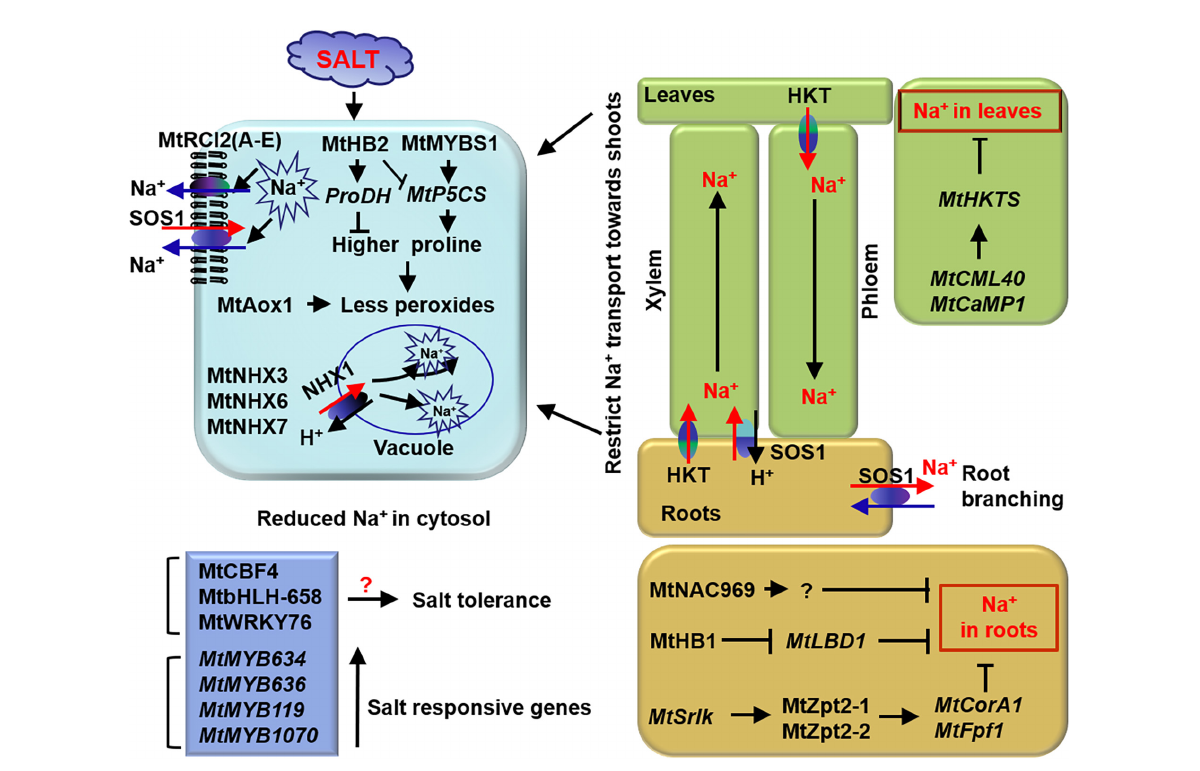
FIGURE2 Tolerant mechanism of M. truncatula to salt stress. MtHB2 and MtMYBS1 and oxidase MtAox1 are involved in osmotic regulation. Membrane proteins MtRCI2 (A–E) and Na + /H + exchangers MtNHX3, MtNHX6, and MtNHX7 play roles in reducing Na + accumulation in cells. MtNAC969, MtHB1, MtZpt2-1, and MtZpt2-1 play roles in reducing Na + accumulation in roots. While, Ca 2 + sensor MtCML40 and MtCaMP1 participate in Na + long-distance transportation regulation between roots and shoots. Light blue box represents cells. Blue boxes represent transcription factors related to salt stress. Green and yellow boxes mean shoots and roots, respectively. The black arrows represent the targets or directions, the red arrows represent transport of Na + and the cross-lines mean